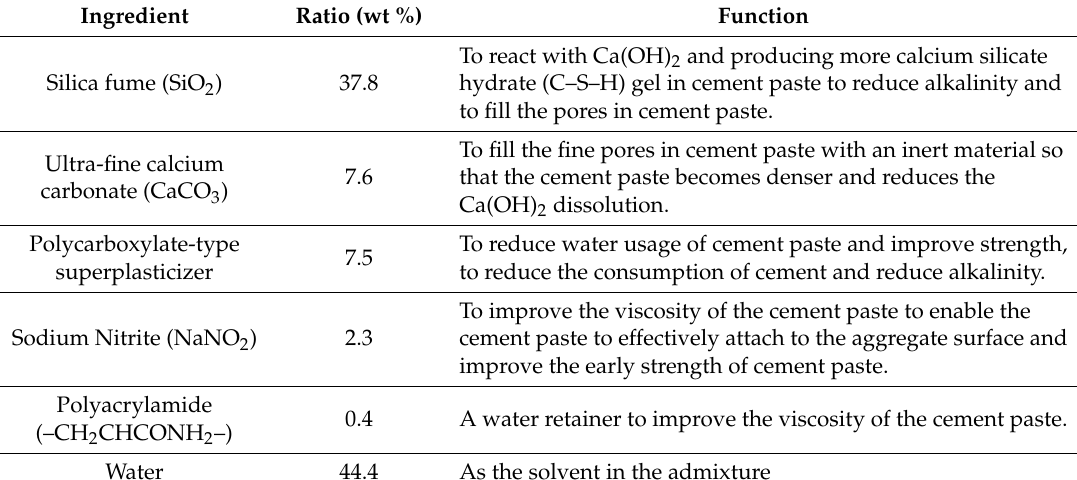
Table 1. The chemical compositions and functions of the admixture Reducing Cement Alkaline (RCA). Ingredient Ratio (wt %) Function To react with Ca(OH) 2 and producing more calcium silicate Silica fume (SiO 2 ) 37.8 hydrate (C–S–H) gel in cement paste to reduce alkalinity and to fill the pores in cement paste.